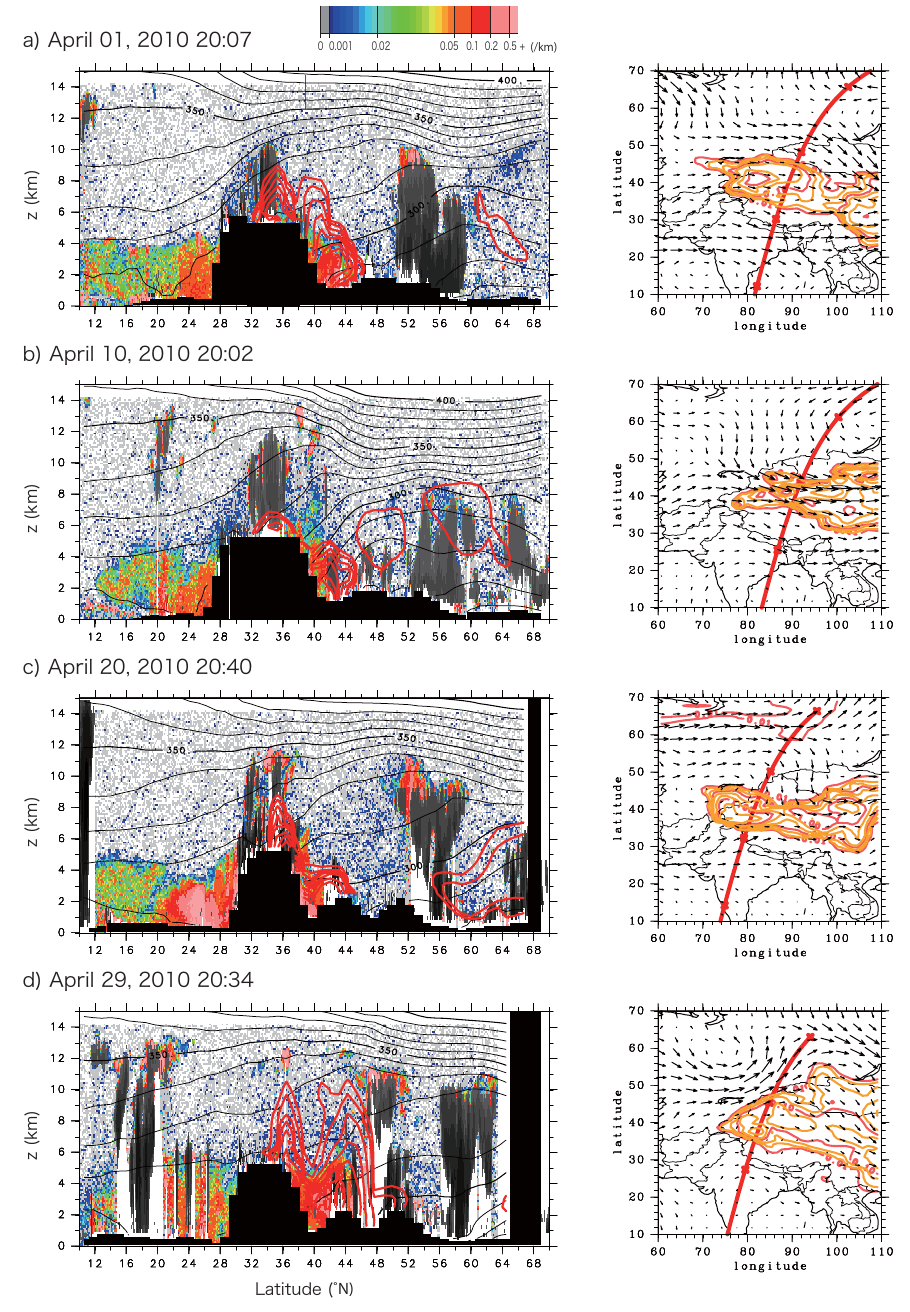
Fig. 5. The same as Fig. 2 but for dust source regions on (a) 1 April, (b) 10 April, (c) 20 April, and (d) 29